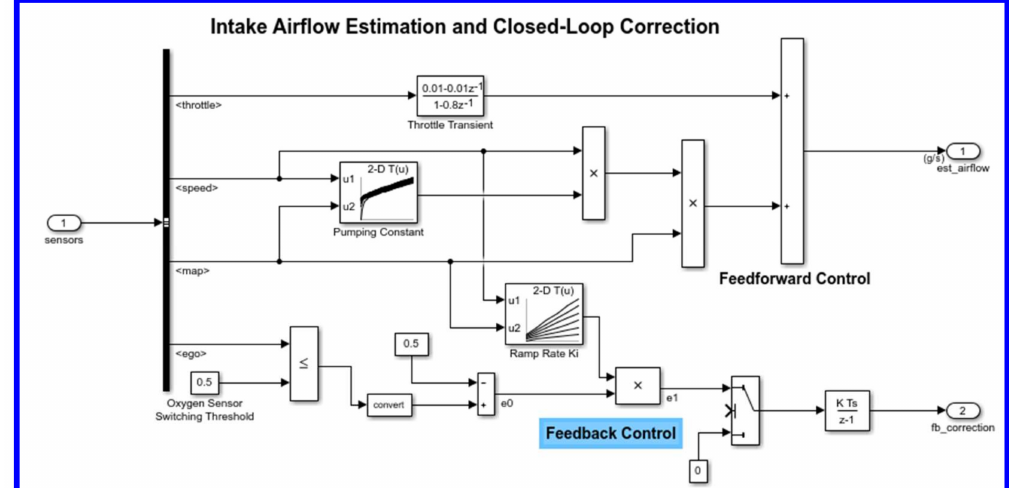
Figure 11. Airflow calculation